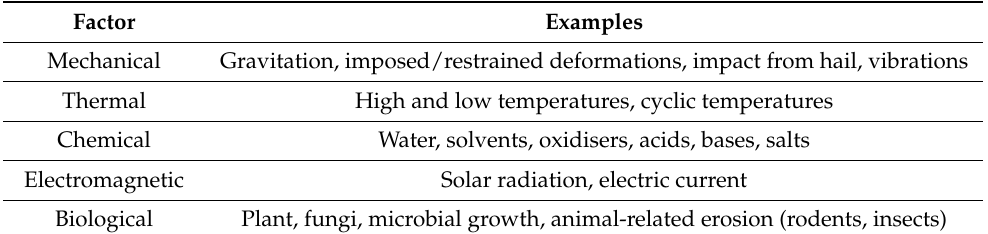
Table 2. Degradation factors that affect the SL of polymeric BEMs; Adapted from Refs. [25,27,32–35]. Factor Examples Mechanical Gravitation, imposed/restrained deformations, impact from hail, vibrations Thermal High and low temperatures, cyclic temperatures Chemical Water, solvents, oxidisers, acids, bases, salts Electromagnetic Solar radiation, electric current Biological Plant, fungi, microbial growth, animal-related erosion (rodents,